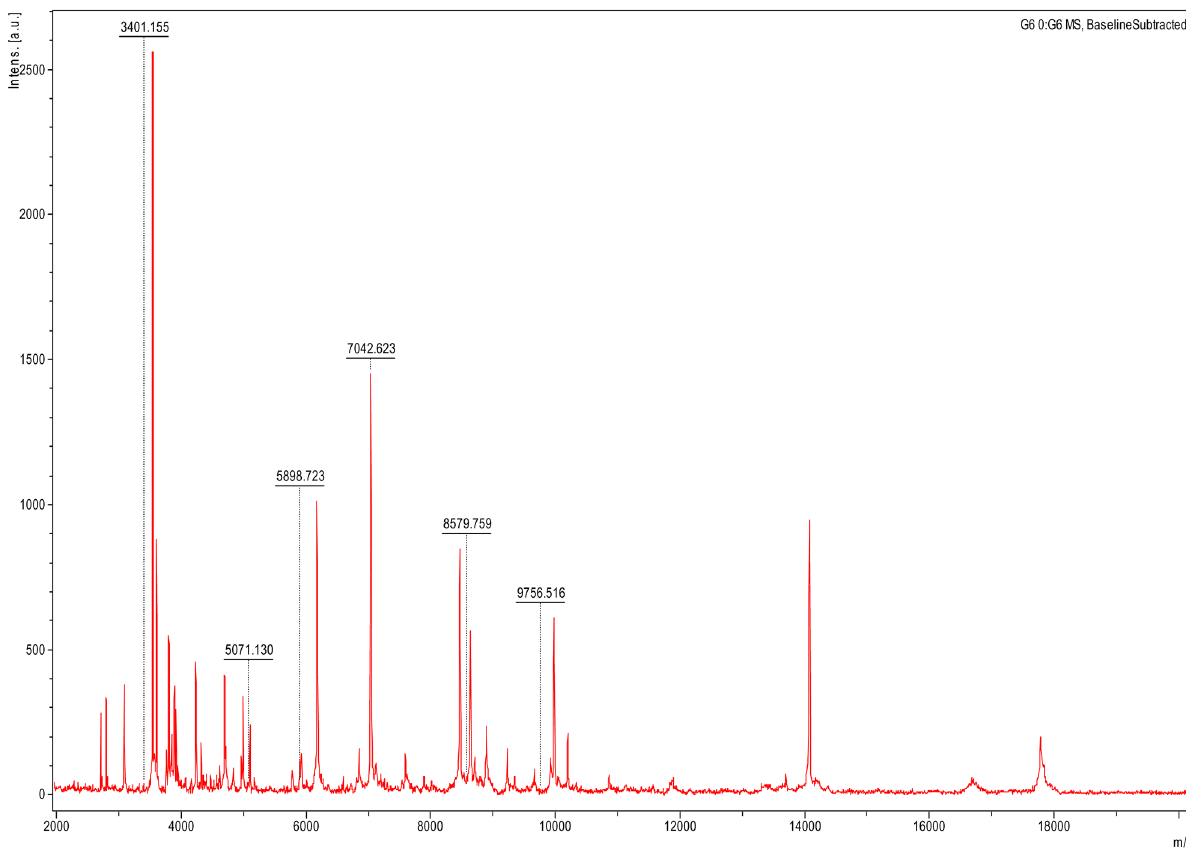
Figure 2. A 6-peak pattern for the specific detection of Borreliacrocidurae in O.sonrai ticks.